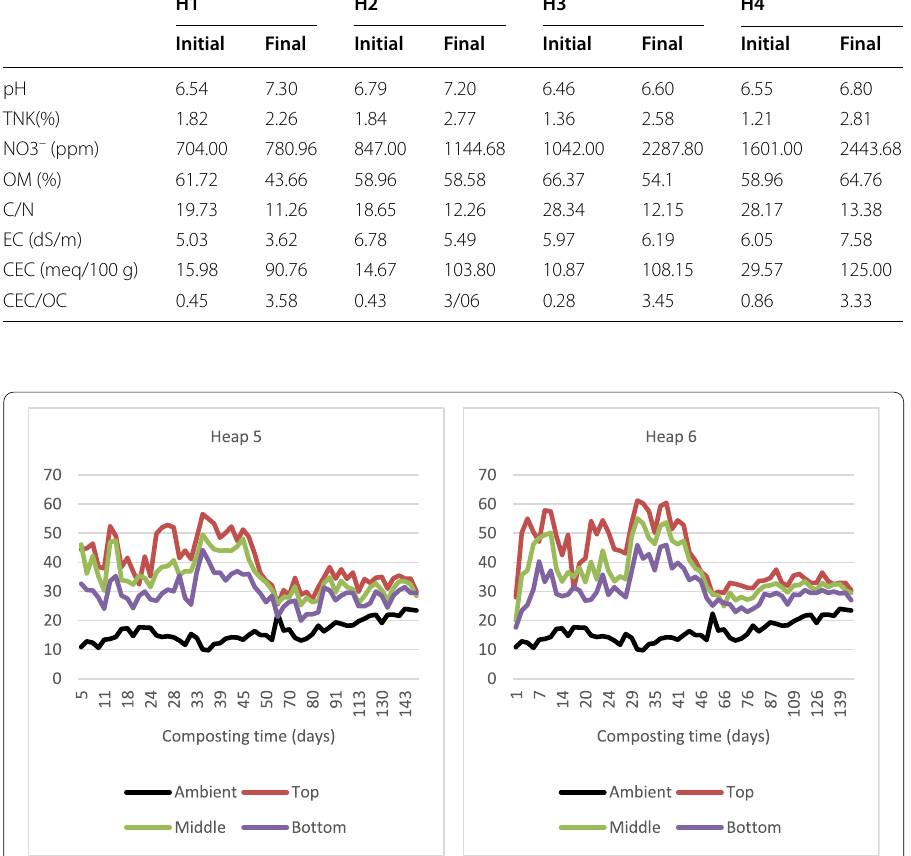
Table 3 Physicochemical properties of composts at initial and final time for H1 to H4 H1 H2 H3